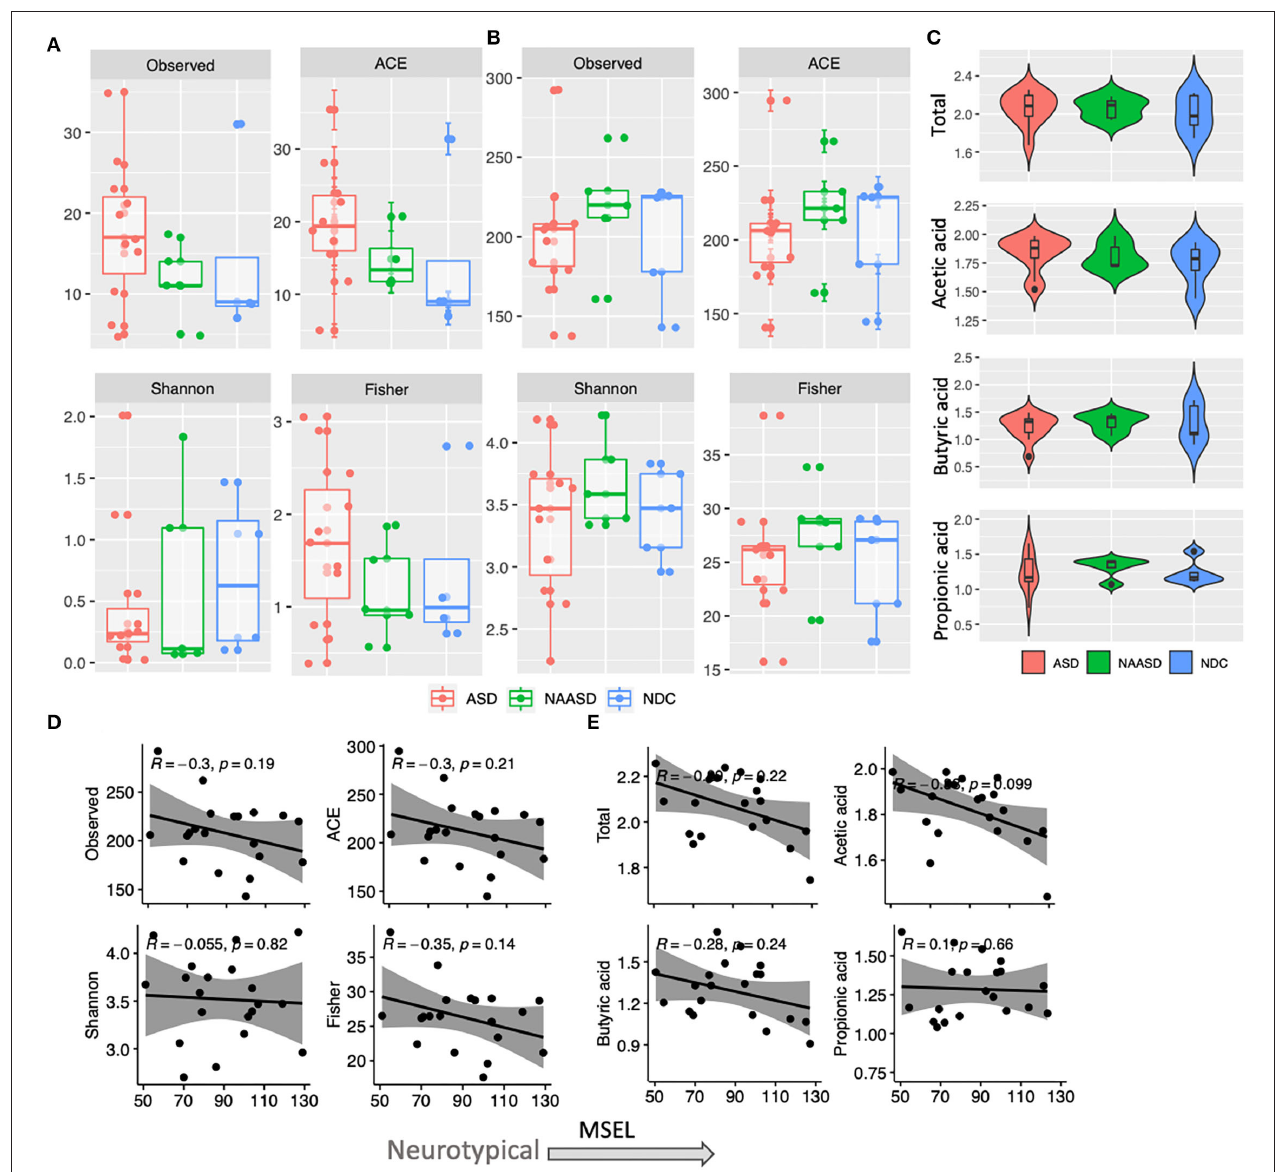
FIGURE 2 | Differences in alpha diversity and SCFA concentration in young children according to autism severity. (A) Fungal community alpha diversity estimates according to CSS groups. (B) Bacterial community alpha diversity estimates according to CSS groups. (C) Total and individual SCFA concentration (log10) in CSS groups. (D) Association between MSEL score and bacterial alpha diversity based on Pearson correlation. (E) Association between MSEL score and SCFA concentration based on Pearson